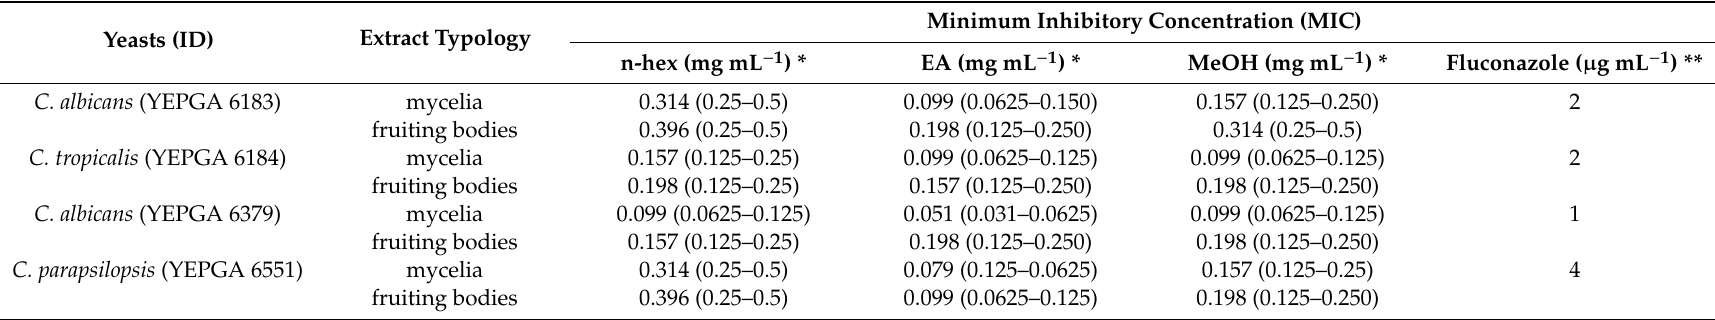
Table 5. Minimal inhibitory concentrations (MICs) of T. goniospermum n-hexane, ethyl acetate and methanol extracts, and fluconazole towards selected